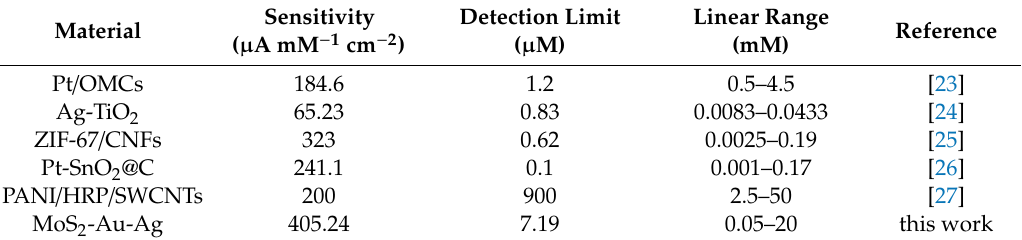
Table 1. Comparison of the performances of various H 2 O 2